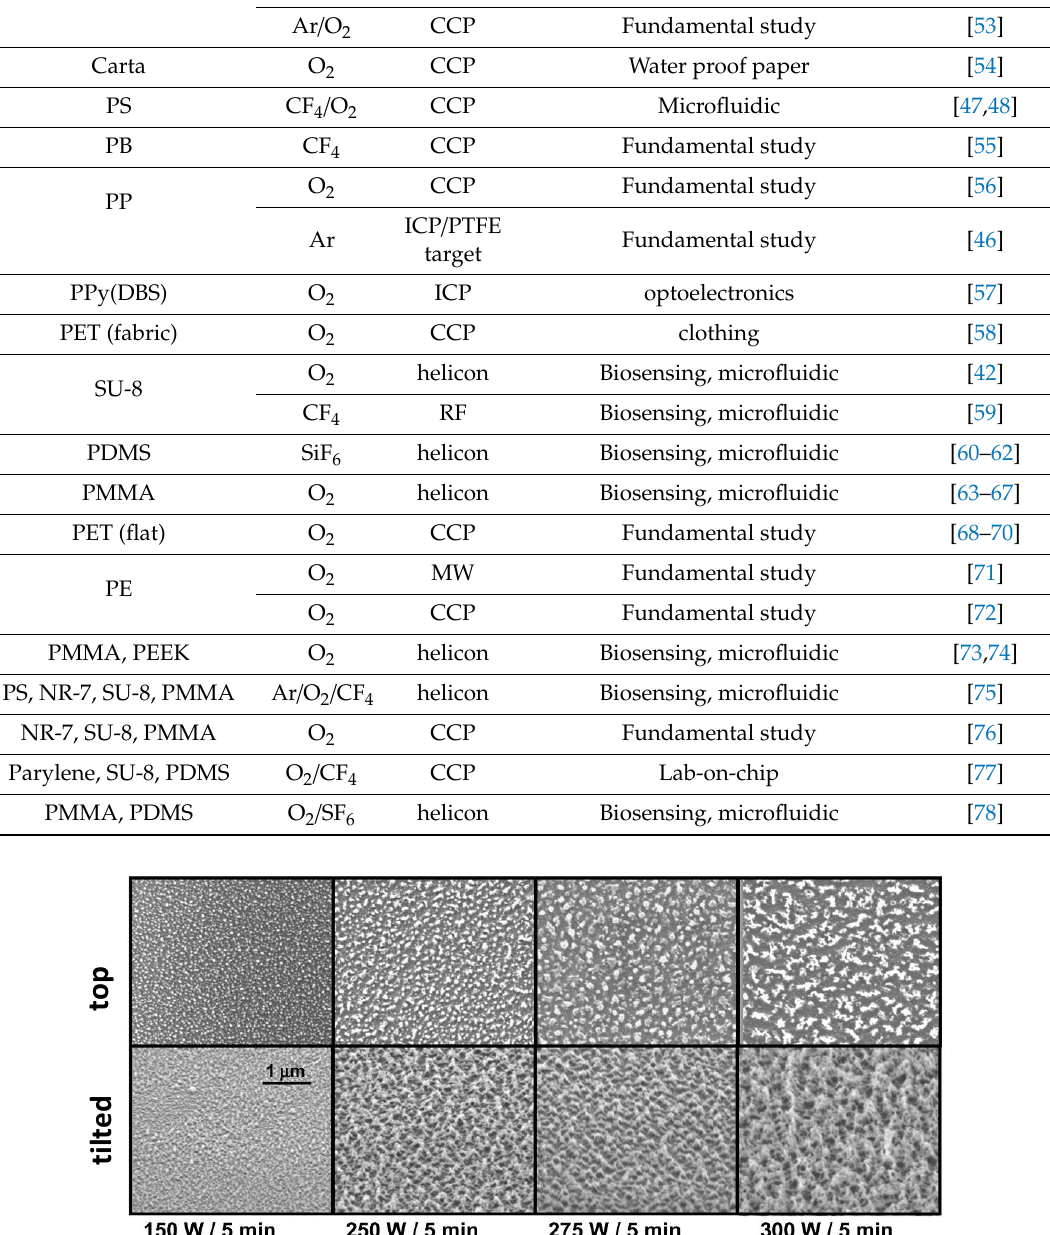
Table 2. Examples of the plasma nano-texturing of different polymers, with indication of the gas feed and reactor configuration used. ICP stands for “inductive coupled plasma”.